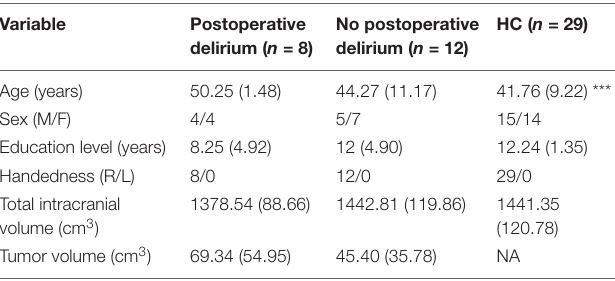
TABLE 2 | Demographic and clinical characteristic among patient with left frontal lobe glioma and healthy controls.